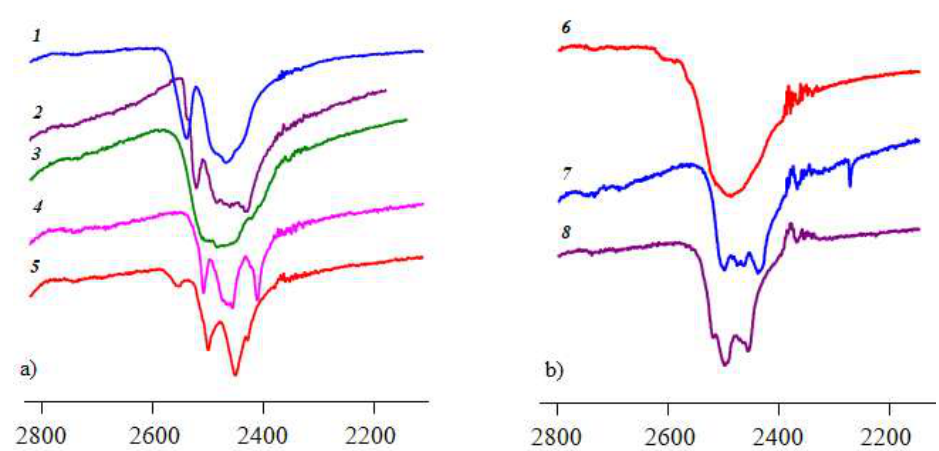
Figure 8. IR spectra (in the ν (BH) region) of compounds with ( a ) [B 10 H 10 ] 2 − and ( b ) [B 12 H 12 ] 2 − anions in comparison with alkali closo -borates: ( 1 ) K 2 [B 10 H 10 ]; ( 2 ) [PhenH] 2 [B 10 H 10 ] ( 4 ); ( 3 ) [H 2 (Phen) 4.5 ][B 10 H 10 ]